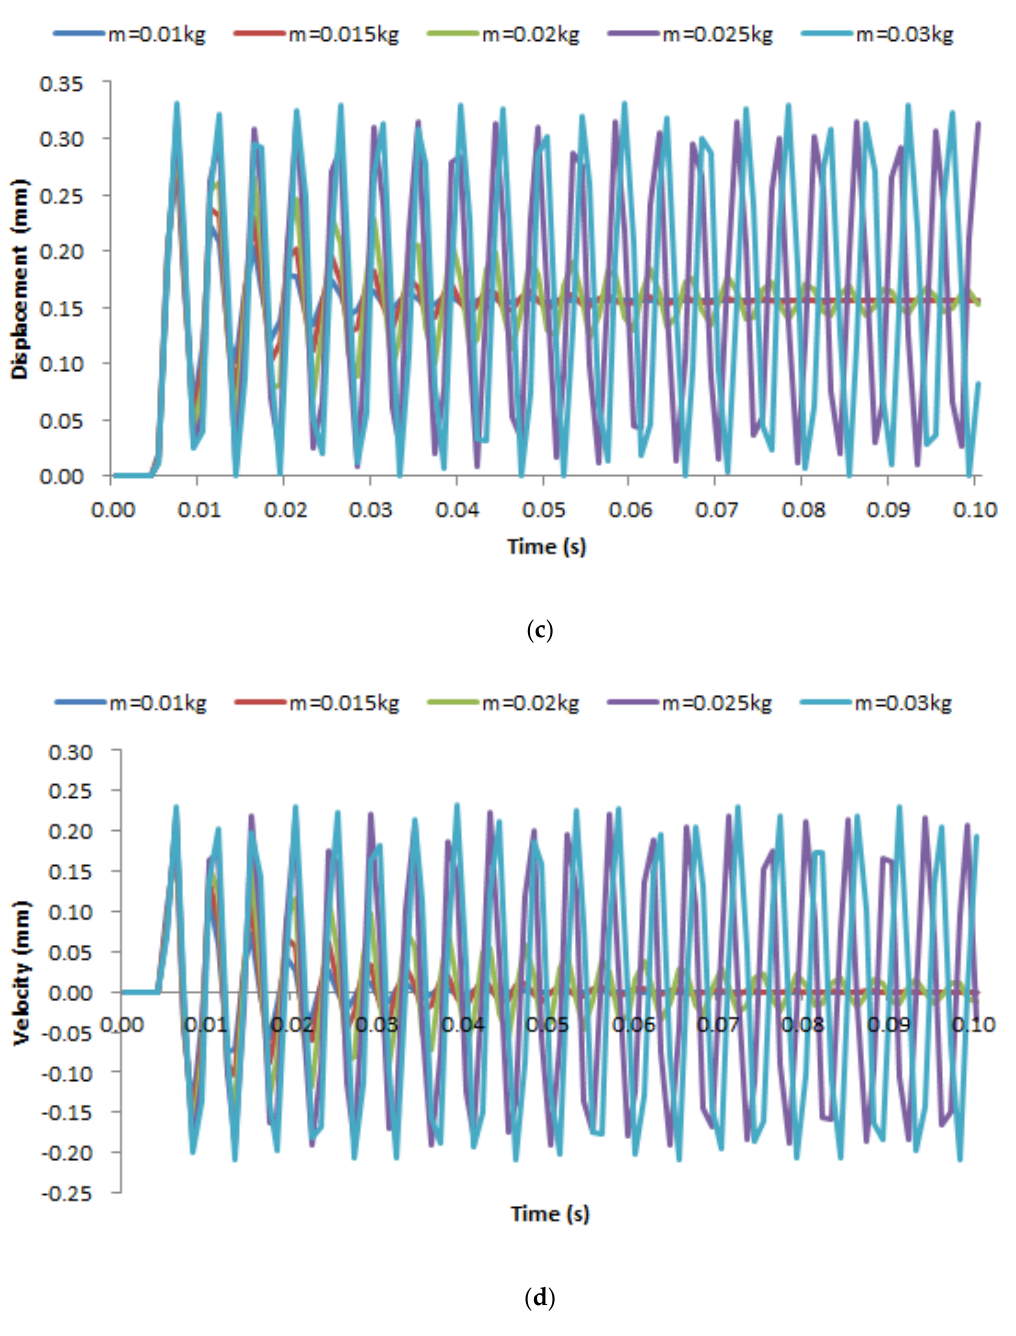
Figure 12. ( a ) The pressure response characteristics — valve element mass: 0.01~0.03 kg. ( b ) The flowrate response characteristics — valve element mass: 0.01~0.03 kg. ( c ) The displacement response characteristics — valve element mass: 0.01~0.03 kg. ( d ) The velocity response characteristics — valve element mass: 0.01~0.03 kg.